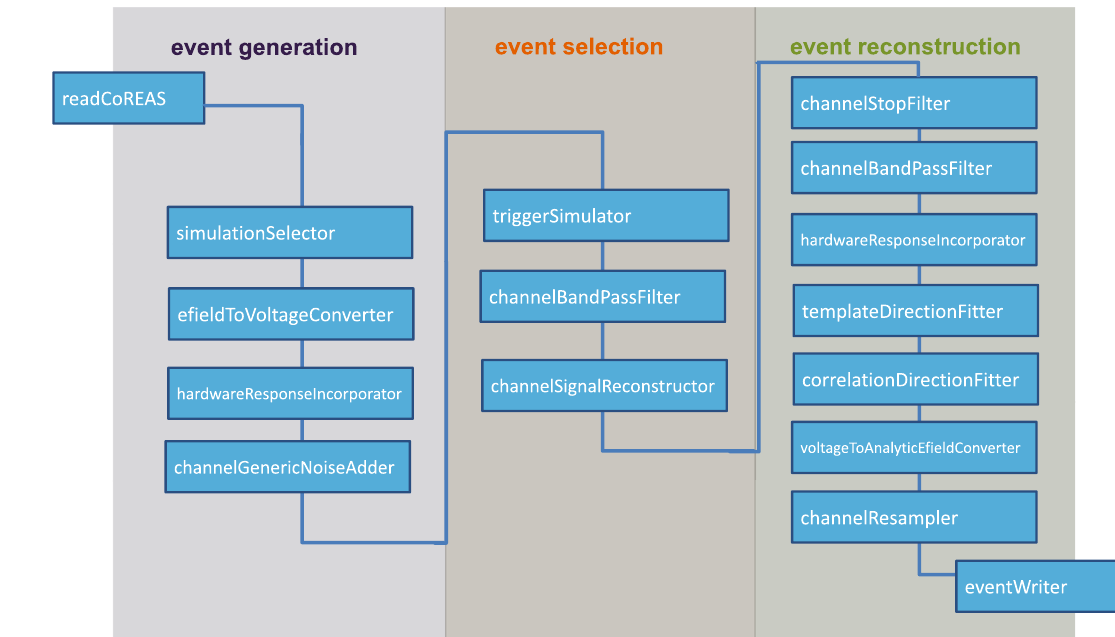
Fig. 4 Schematic overview for a full reconstruction cycle for an event